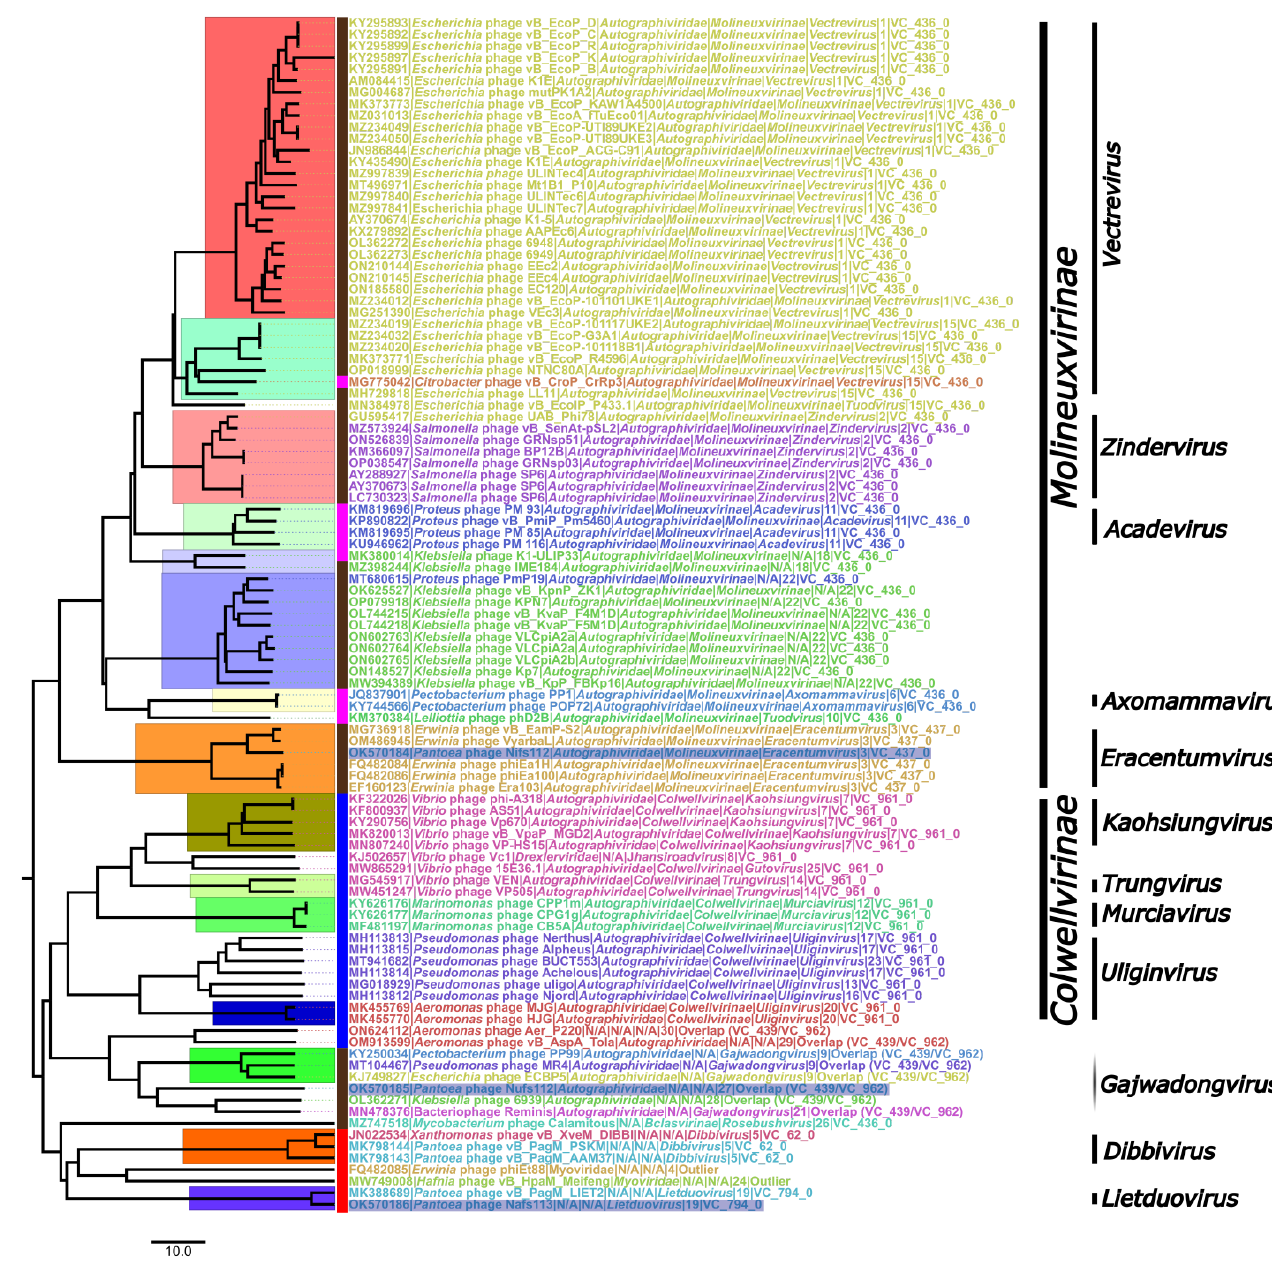
Figure 5. The NJ tree from a pairwise intergenomic distance matrix generated by VIRIDIC for a dataset comprising the studied phages and their first neighbors identified by the vConTACT2 analysis (n = 103). The tree is midpoint rooted and drawn to scale; the scale bar represents 10% genome nucleotide sequence divergence. Tip labels follow the format of “Genome accession|Phage|Family|Subfamily|Genus|VIRIDIC genus cluster (at least 70% intergenomic similarity)|vConTACT2 status or cluster”. Tip labels of the studied phages are highlighted in blue. The taxonomical information was retrieved from the genome accession-associated metadata at the time of writing. Black bars after the tips show phage subfamily- and genus-level annotations, where two or more corresponding rank phages were neighbors in the tree. Monophyletic clades corresponding to VIRIDIC genus-level clusters are also highlighted by arbitrarily colored rectangles in the tree. The color of the rectangle between the external leaf of the tree and the corresponding tip indicates the “first neighbor” status regarding the studied phages based on the vConTACT2 analysis and is as follows: brown—Nifs112 and Nufs112; magenta—Nifs112; blue—Nufs112;